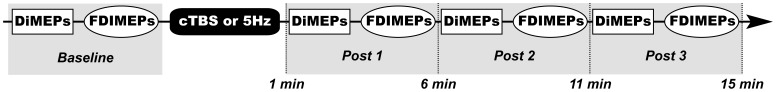
Experimental design.Twenty motor-evoked potentials were recorded for both the diaphragm (DiMEPs) and the first dorsal interosseous (FDIMEPs) at baseline and at three time points (Post 1, Post 2 and Post 3) after the rTMS protocols (cTBS or 5 Hz) over the supplementary motor area (SMA). The time indicates time after the end of rTMS.